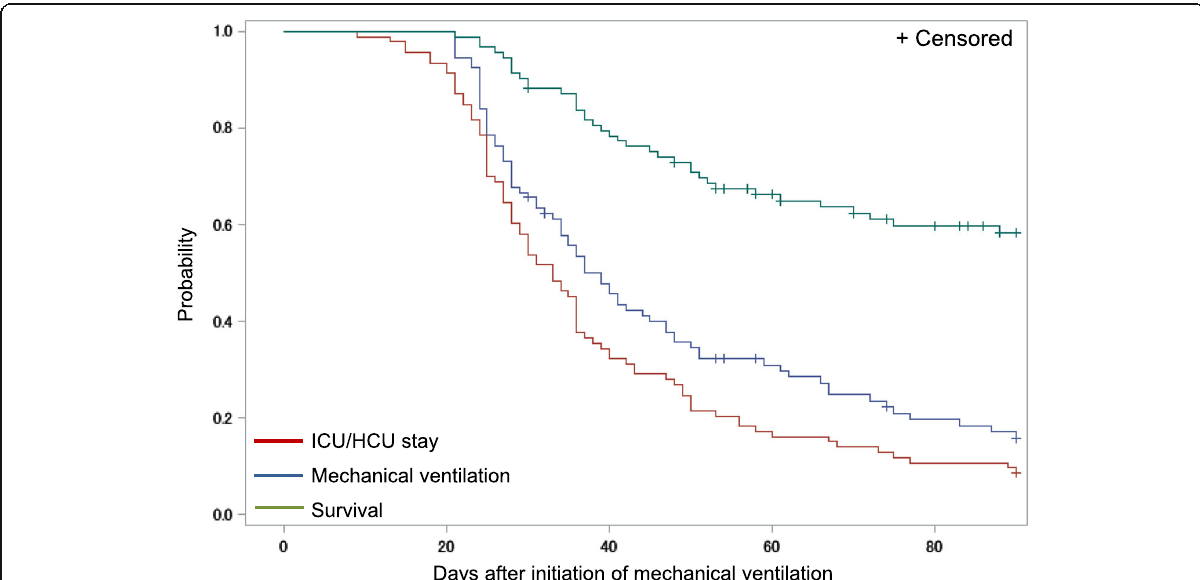
Fig. 2 Kaplan – Meier curves for survival, ICU/HCU stay, and continuation of mechanical ventilation (MV) in the patients mechanically ventilated for > 21 days ( N = 93). The survival curve had a gentle slope from 21 to 90 days after initiation of MV. The curves of MV withdrawal and ICU/HCU discharge were almost identical, having an initial steep slope and transition to a gentle slope in the last third of the curves